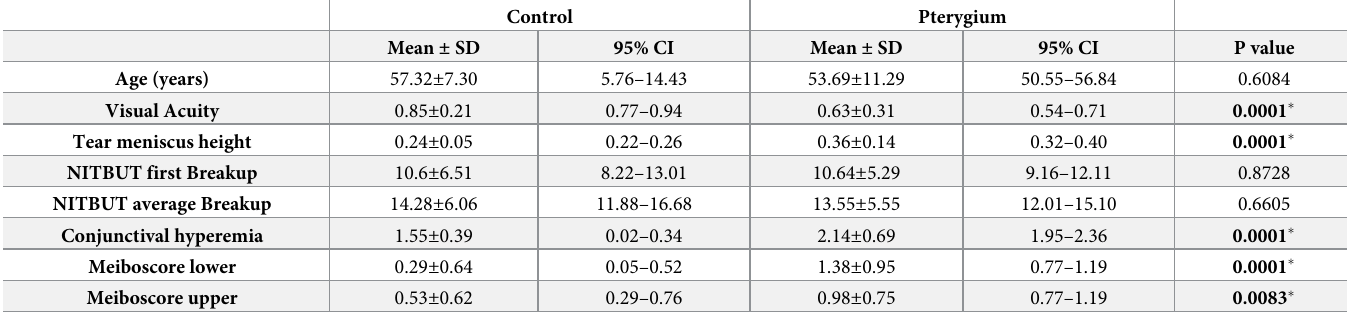
Table 1. Comparisons of ocular Surface parameters in pterygium and healthy participants.